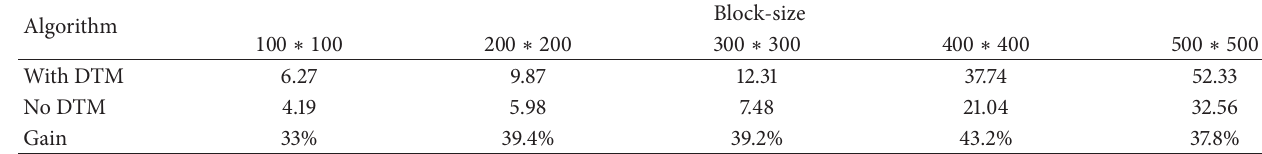
Table 4: Block-count is 5 ∗ 5 on Grid5000